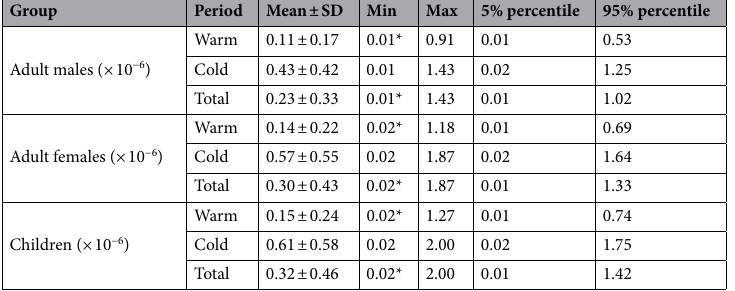
Table 1. Statistical summary of ILCR (× 10 −6 ) calculated for different population groups during the cold season, the warm season and the entire study period (Total). Data marked as (*) show values × 10 −8 .